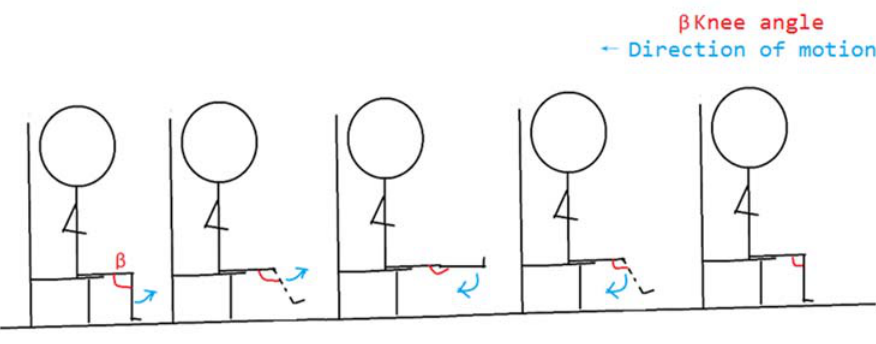
Figure 6. Knee joint stretching and bending.